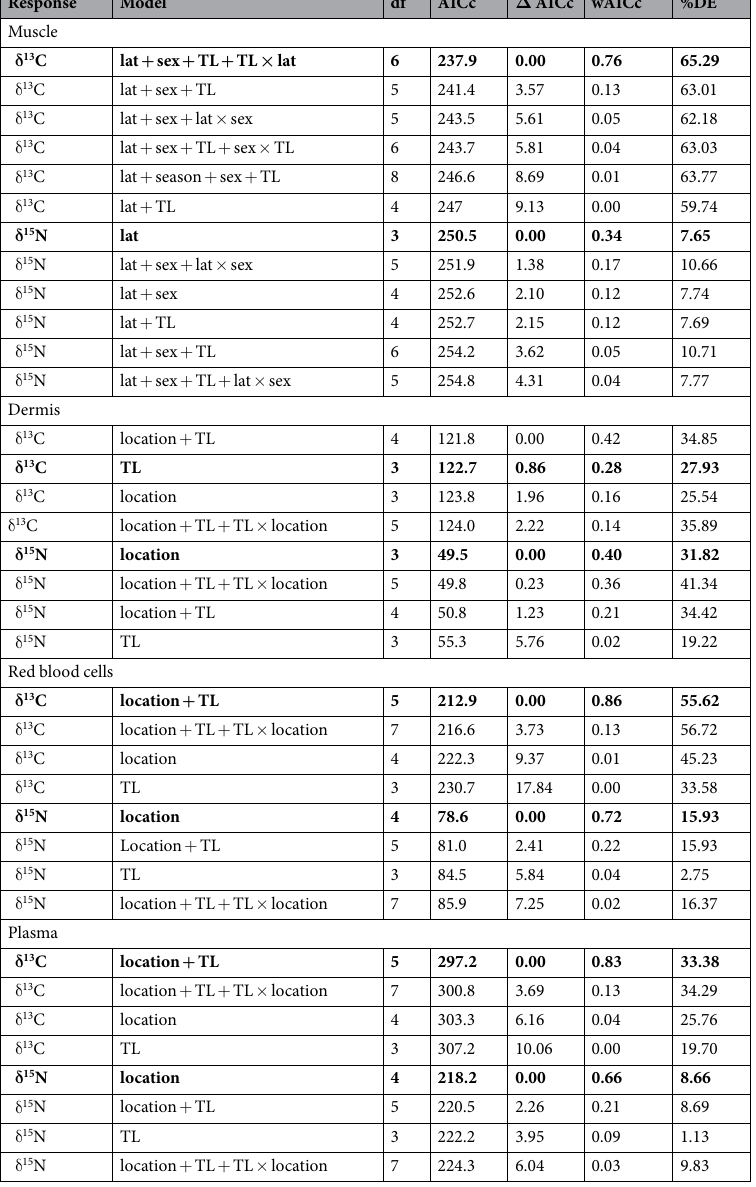
Table 3. Ranked generalised linear models of δ 13 C and δ 15 N for each tissue. The top six models for each response are shown; values in bold indicate the top ranked model (or the most parsimonious model). Degrees of freedom (df), sample corrected Akaike’s Information Criterion (AICc), change in AICc relative to the model with the lowest AICc value ( Δ AICc), relative AICc weight (wAICc) and percent deviance explained (DE%). Lat = latitude, TL = total length